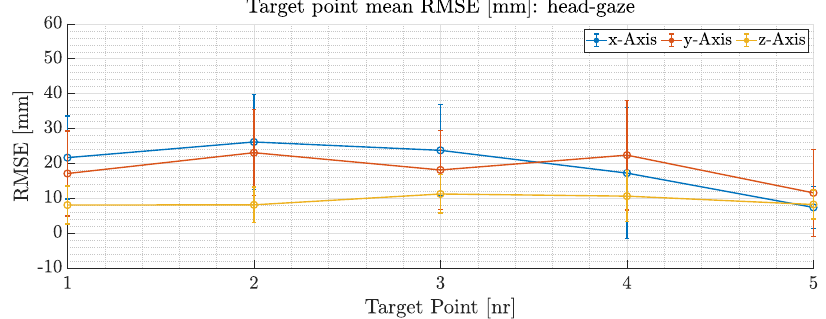
Figure 15. Mean RMSE error of the head-gaze for each individual axis along target points throughout five trials during robotic